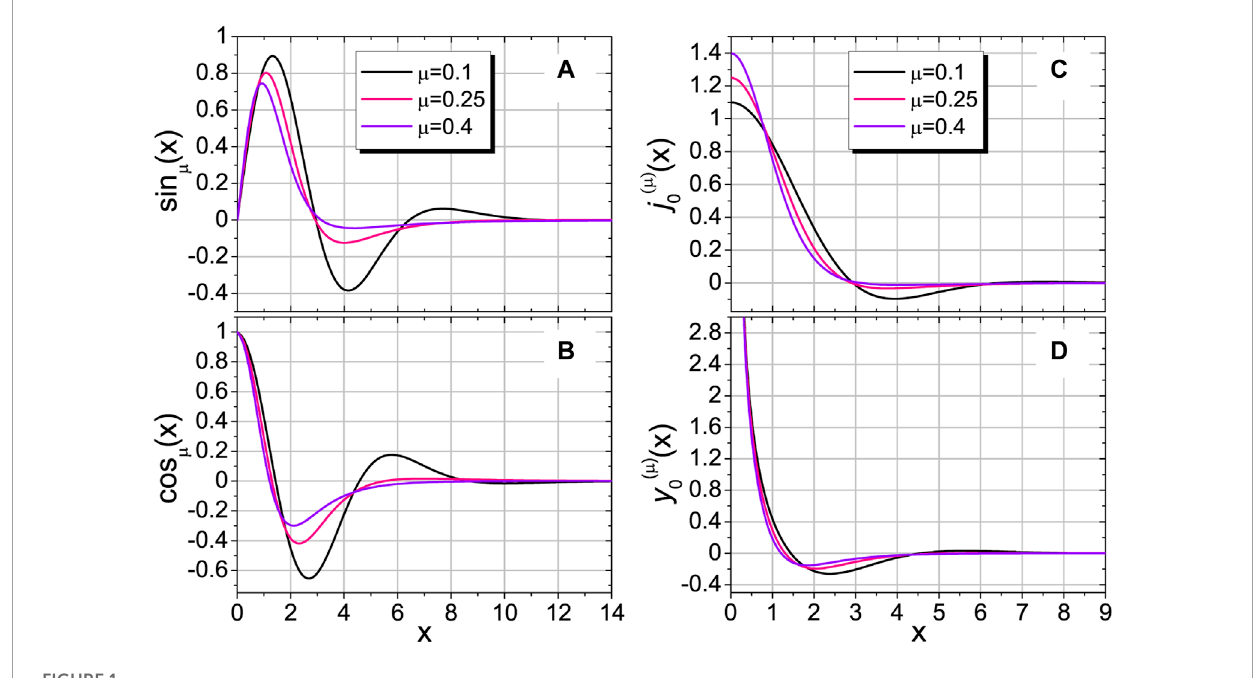
FIGURE 1 Basic μ -deformed trigonometric (A, B) and spherical (C, D)